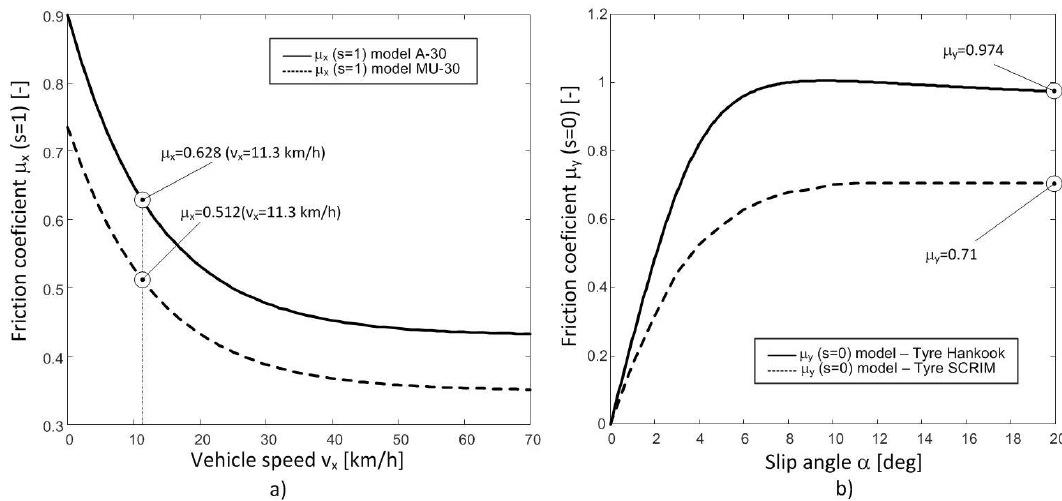
Figure 9. Longitudinal and lateral friction coefficients. ( a ) Longitudinal friction coefficient versus vehicle speed on roads A-30 and MU-30. ( b ) Lateral friction coefficient. Hankook and SCRIM tires on steel surface.